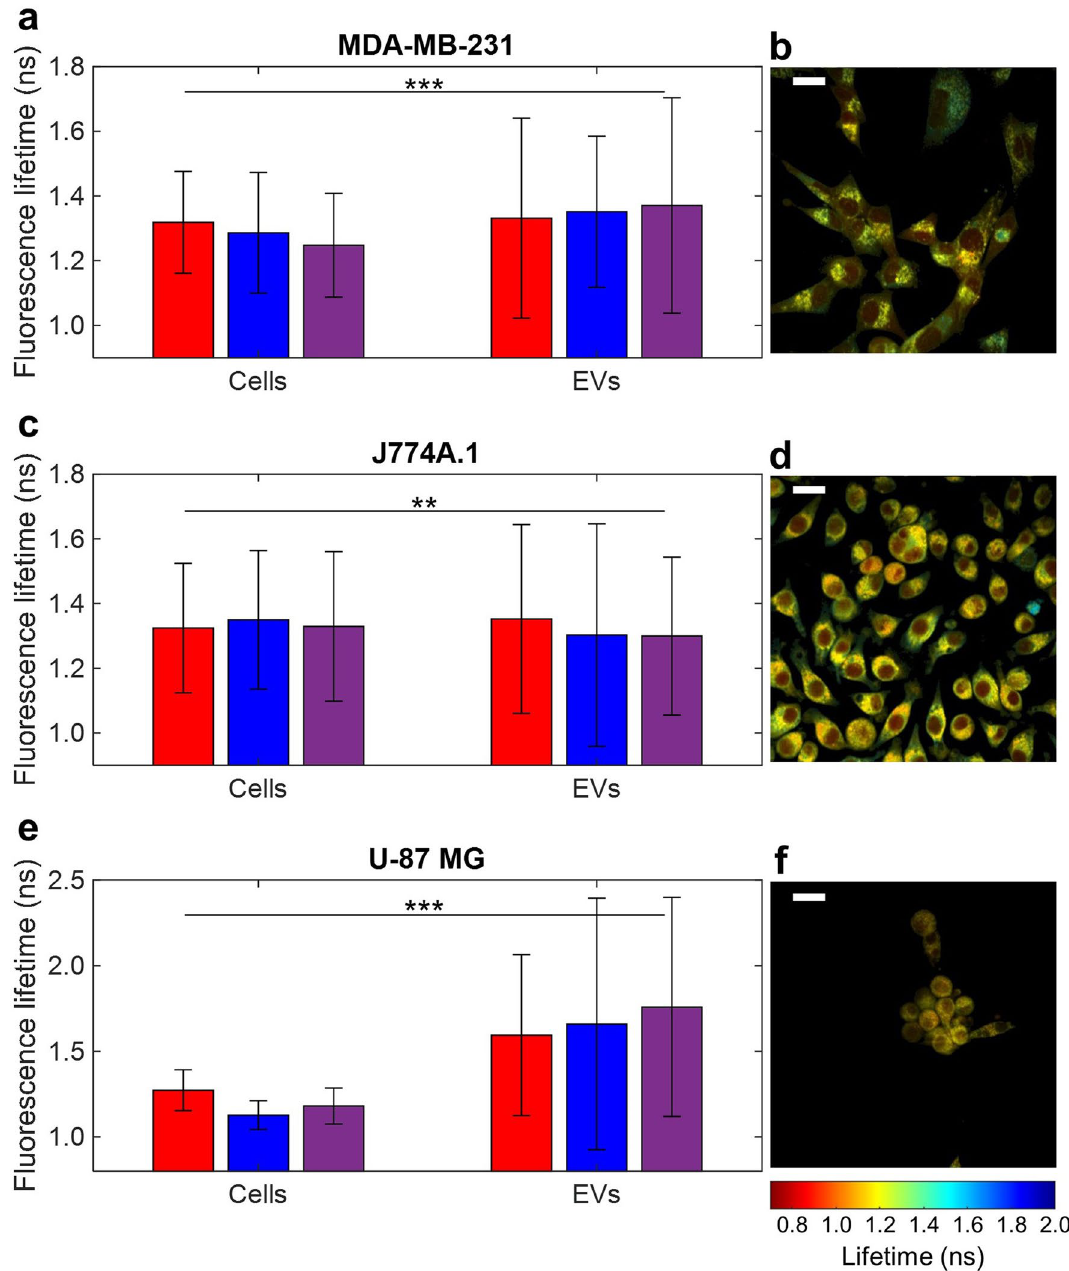
Figure 4. Fluorescence lifetime values of extracellular vesicles (EVs) and their parent cells for three cell lines: ( a , b ) MDA-MB-231 human epithelial breast cancer, ( c , d ) J774A.1 mouse macrophage, and ( e , f ) U-87 MG human glioblastoma. Mean and standard deviation of fluorescence lifetime values are indicated in the bar charts for three different replicates of each cell line, with each replicate indicated by color (replicate 1: red , replicate 2: blue , replicate 3: purple ), in ( a , c , e ). Each replicate consisted of 4 fields-of-view (FOVs) for cells and 16 FOVs for EVs. One example FOV of each cell line is given as well: ( b ) MDA-MB-231, ( d ) J774A.1, and ( f ) U-87 MG. **Indicates P < 0.01, *** indicates P < 0.001. First replicate is indicated in red, second in blue, and third in purple. Scale bars represent 20 μm. The total number of vesicles (n) for each experimental group pooled together is as follows: MDA-MB-231 n = 561, J774A.1 n = 968, U-87 MG n = assumed to be primarily from NADH, since there is about 10 times more NAD+/NADH in cells than NADP+/ NADPH 29 . This implies that the subpopulation of EVs that overlaps with the cells on the phasor plot (Fig. 5e) likely also has a FLIM signature dominated by NADH. Furthermore, as shown in Fig. 5c,d, although the fluo- rescence lifetime values of the EVs are significantly different from those of the main cellular components, they